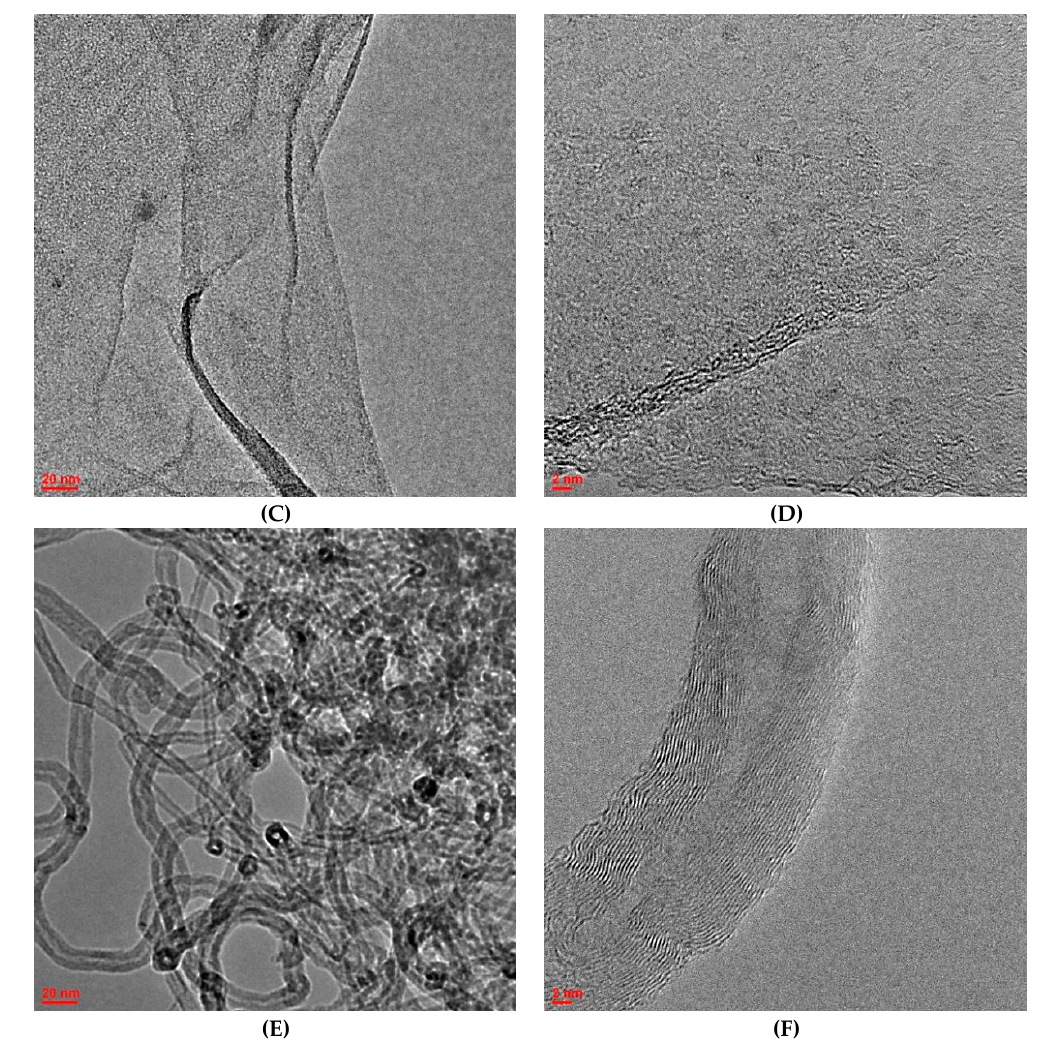
Figure A2. HRTEM images of commercial CNMs used: ND ( A , B ), rGiO ( C , D ), multi-walled carbon nanotubes (MWCNT) ( E , F ); images are similar to ones for modified samples ND–COOH, rGiO–H and MWCNT–H, respectively. Adapted from [Kazakov, A.G.; Garashchenko, B.L.; Yakovlev, R.Y.;